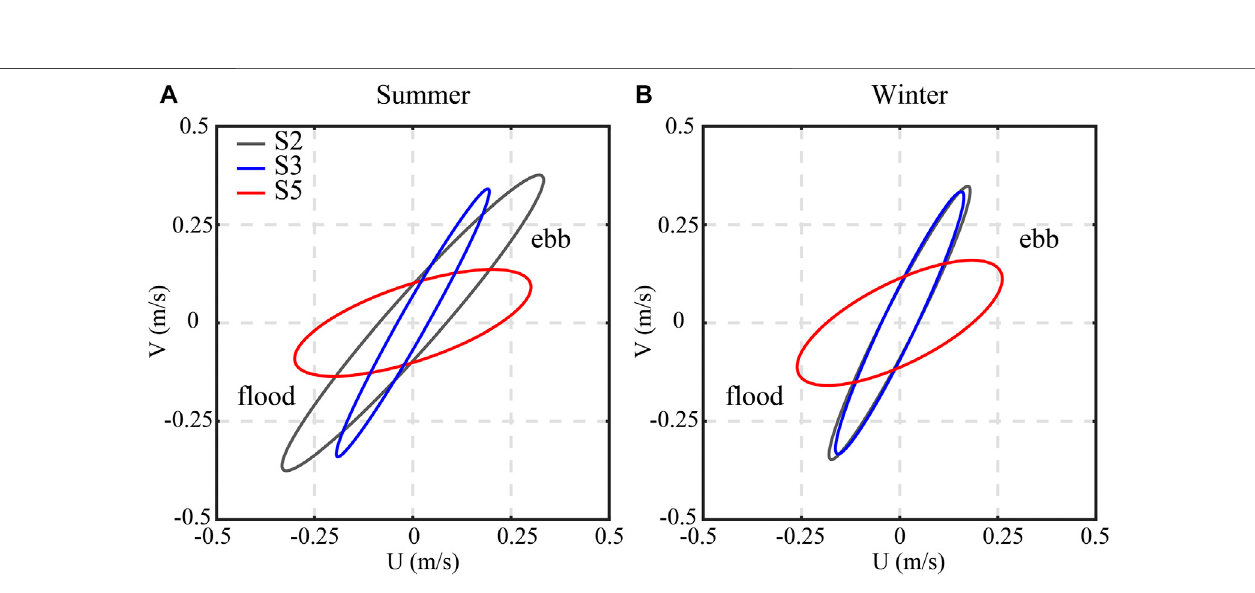
Frontiers in Earth Science |